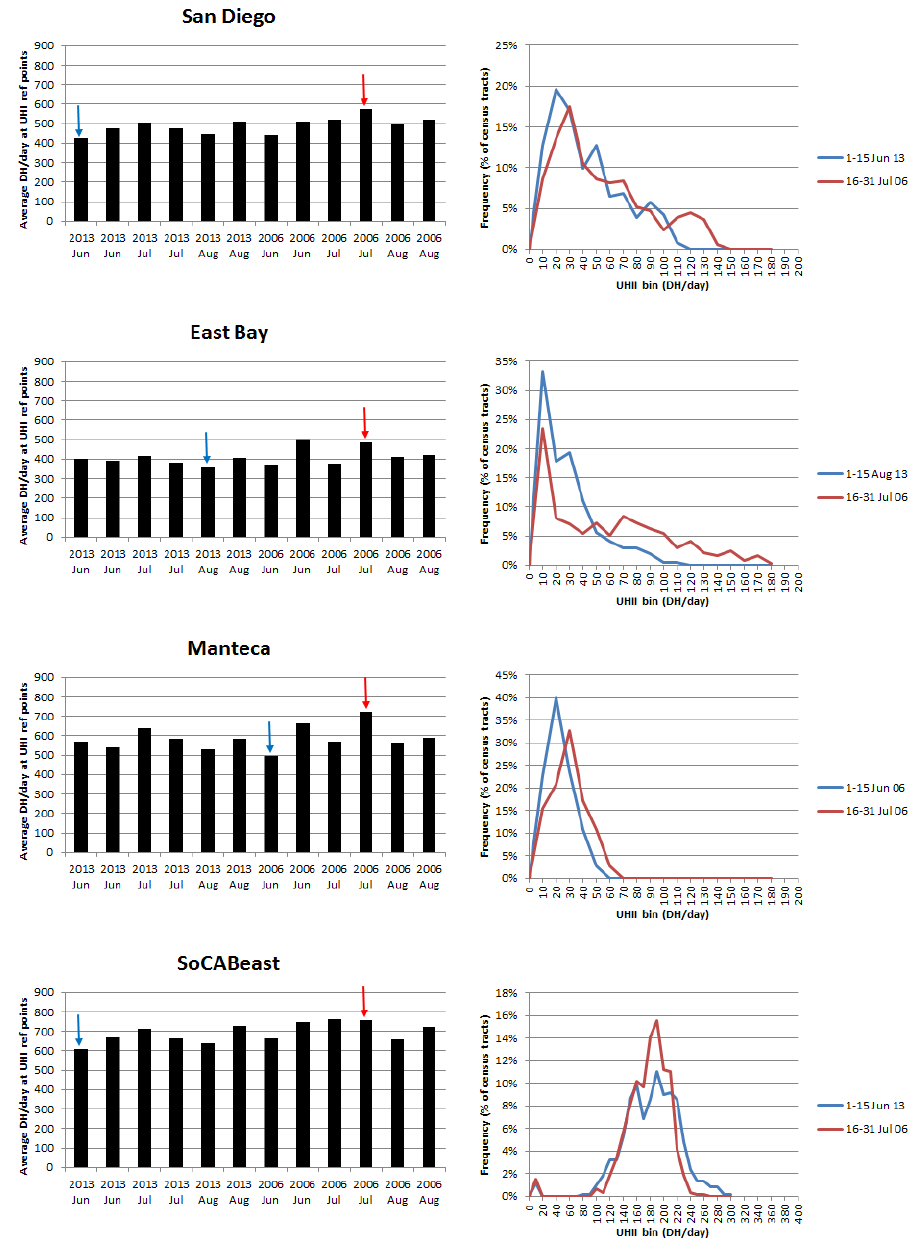
Figure 9. ( Left ) UHII (DH/day) at UHI reference points of each region (each month is divided into two halves: days 1–15 and 16–30 or 31); ( Right ) frequency distribution of census tracts in UHII bins for the selected periods.